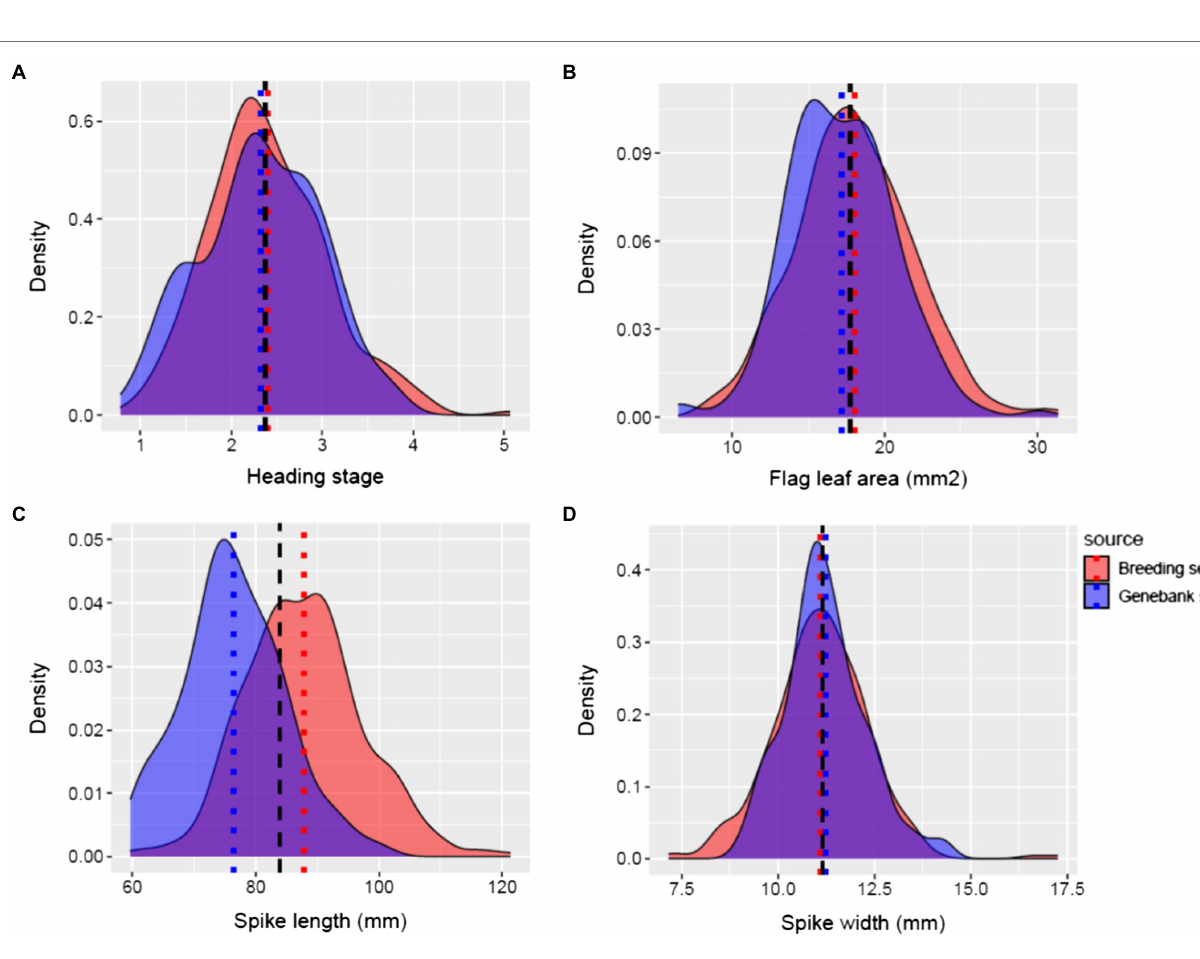
FIGURE 4 | Phenotypic distribution of (A) heading stage, (B) flag leaf area, (C) spike length, and (D) spike width. Breeding set (red) and genebank set (blue). The black dashed line represents the overall mean for combined genotypes from both breeding set and genebank